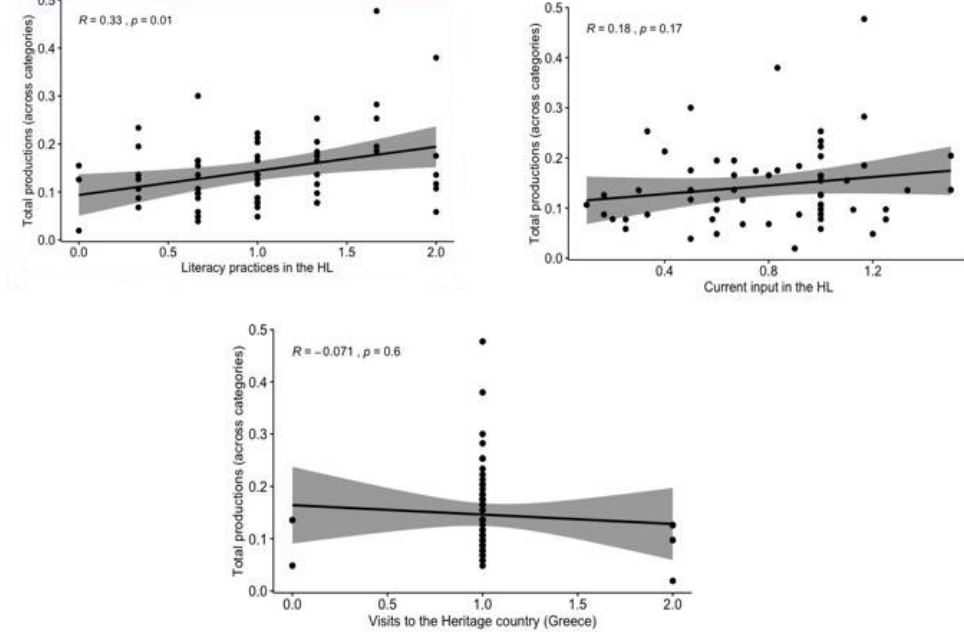
Figure 12. Correlations between frequency of total productions across agreement categories and literacy practices in the HL ( up left ), current input in the HL ( up right ) and visits to the Heritage country ( down ) within the USA group.